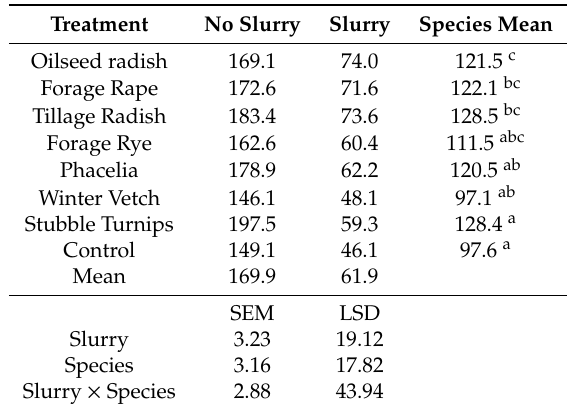
Table 7. Total apparent N recovery (TANR) (%).